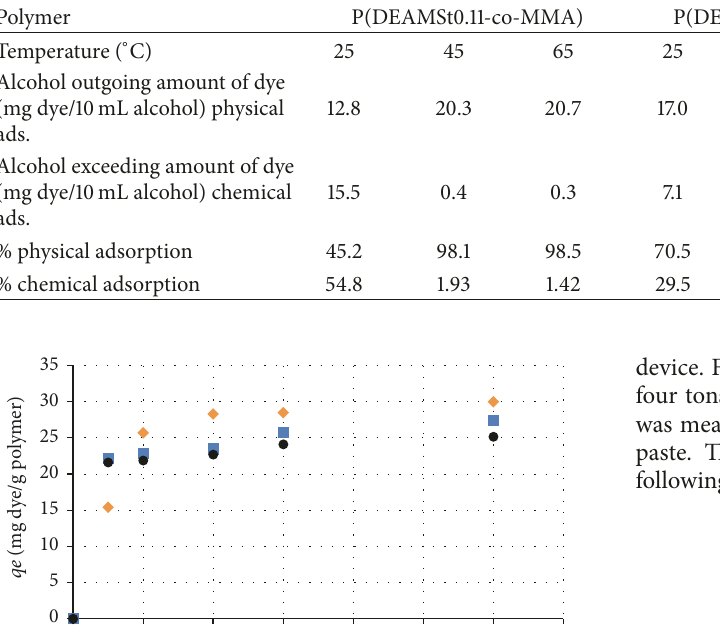
Table 4: The physical and chemical adsorption amount of P(DEAMSt-co-MMA).